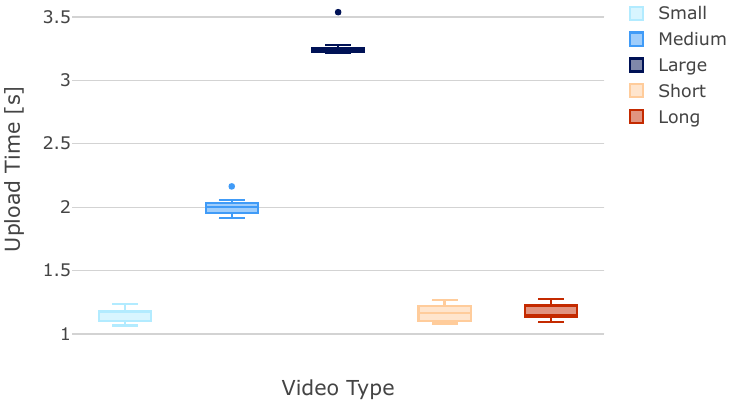
Figure 13. Upload Time Distributions for each video type using the satellite (SAT) Internet connection